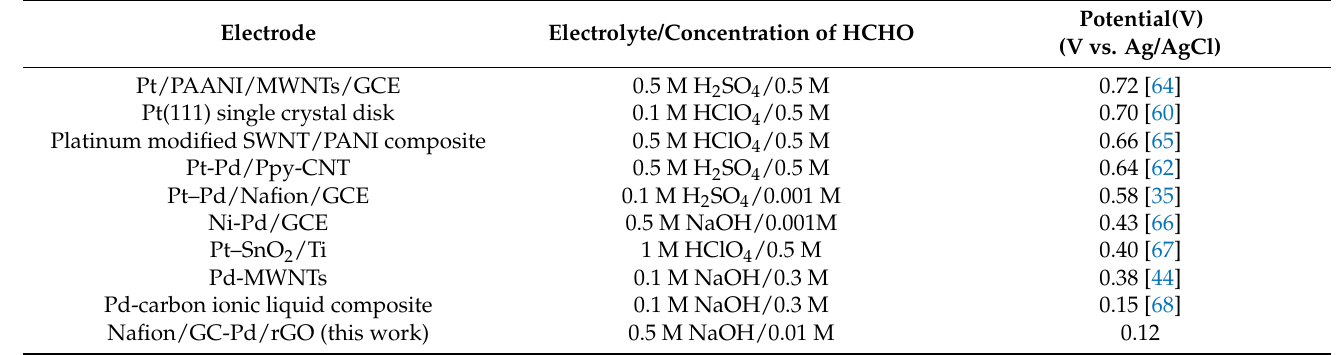
Table 1. The comparison of electrochemical behavior for formaldehyde oxidation from the present work with previous